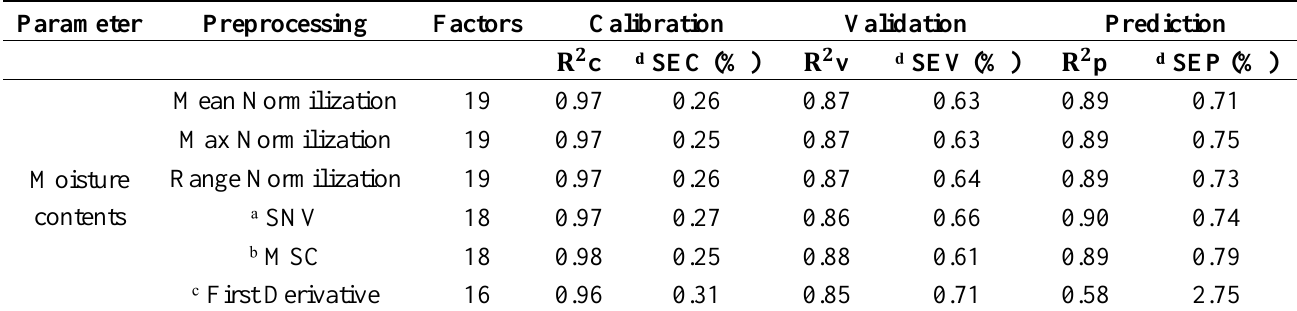
Table 1. PLS results with full spectral region (400–1,000